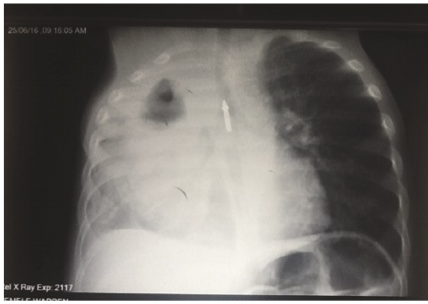
Figure 2: Chest X-ray of the boy at the time of the incident. The foreign body is visible in the chest. There is massive right pleural effusion and sign of esophageal perforation.